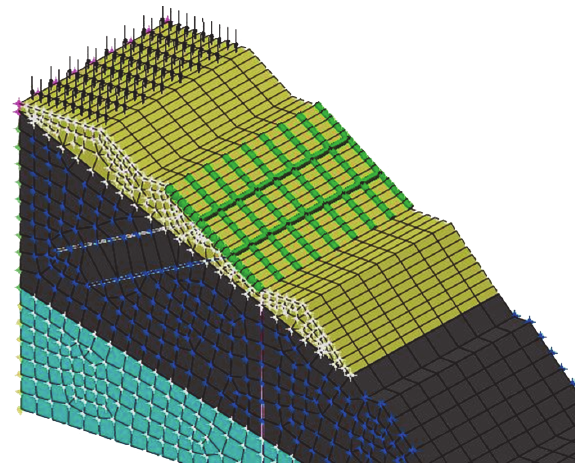
Figure 6: Sine motor vehicle load curve